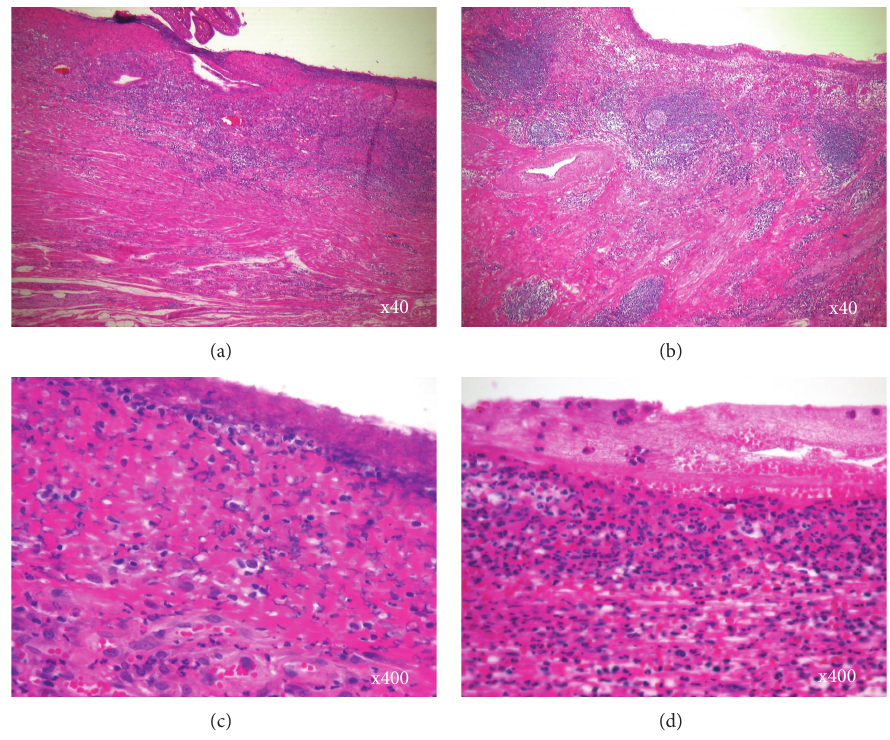
Figure5:Histopathologicalexaminationrevealedthatanulcerscaratthedistalsidehadmainlyfibrosis((a)and(c)),whilelymphoidfollicles, infiltration of monocytes, and neutrophils were more noticeable in the wide ulcer on the proximal side ((b) and (d)). Hematoxylin-eosin staining. Original magnification 40x: (a) and (b); 400x: (c) and